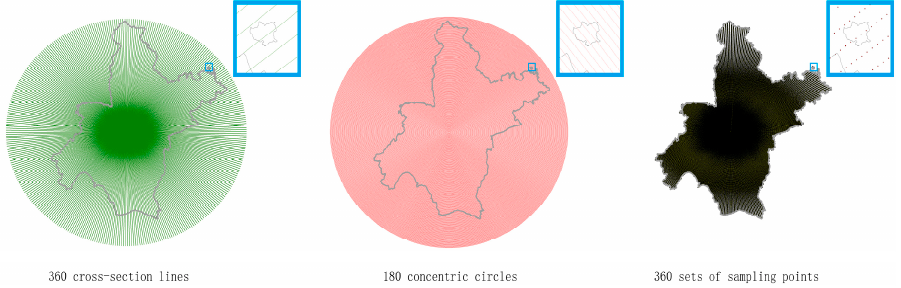
Figure 3. Spatial sampling point design process.